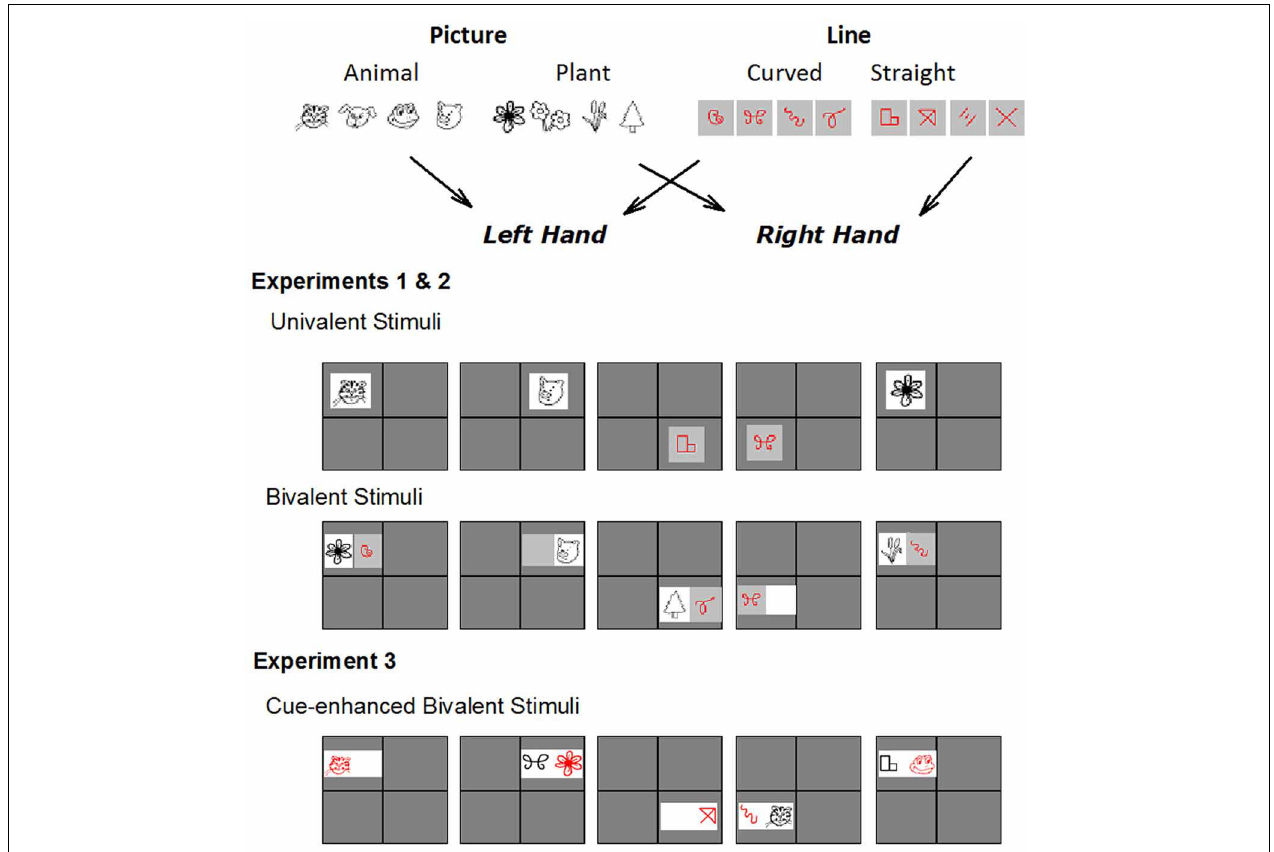
FIGURE 1 | Alternating runs paradigm is shown, illustrating tasks used for each experiment. Participants switched between picture (animal or plant?) and line (curved or straight?) tasks using an AABB sequence. Response keys were bivalently mapped to the two tasks. In Experiments 1 and 2, the univalent condition included an exemplar only from the relevant task on each trial. The bivalent